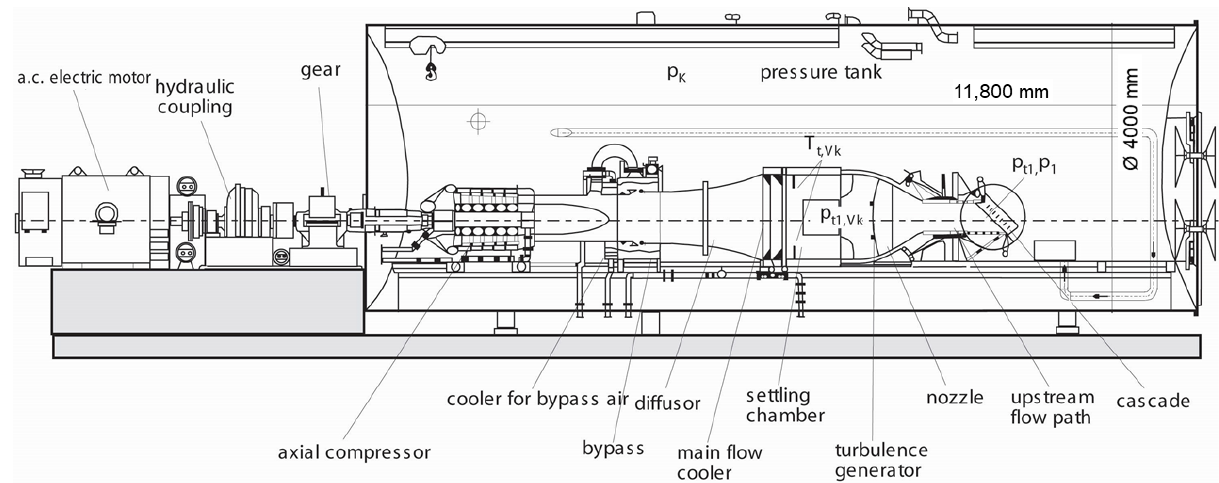
Figure 1. Main components of the High-Speed Cascade Wind Tunnel before